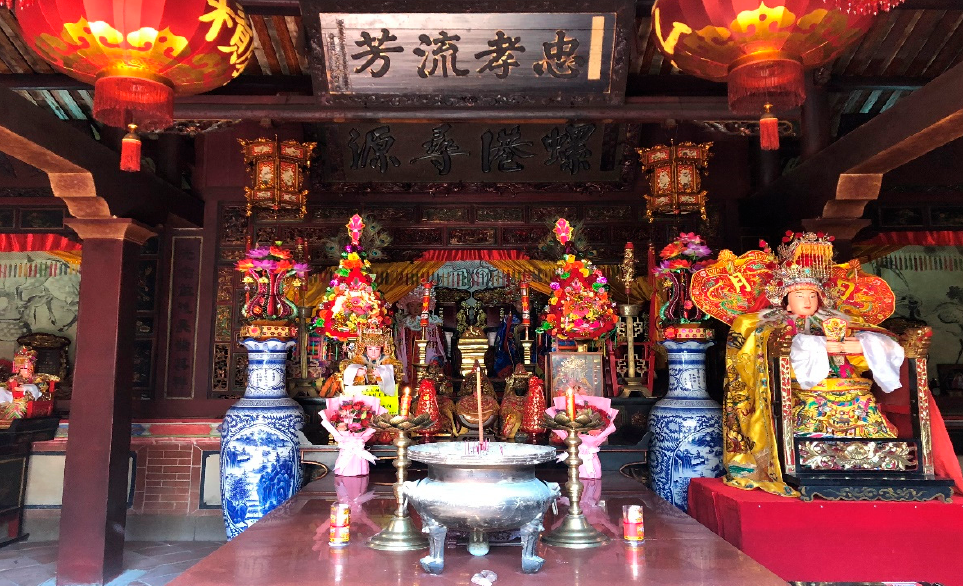
Figure 5. The statues of Mazu’s parents at the central shrine; Mazu’s statue on the front in the